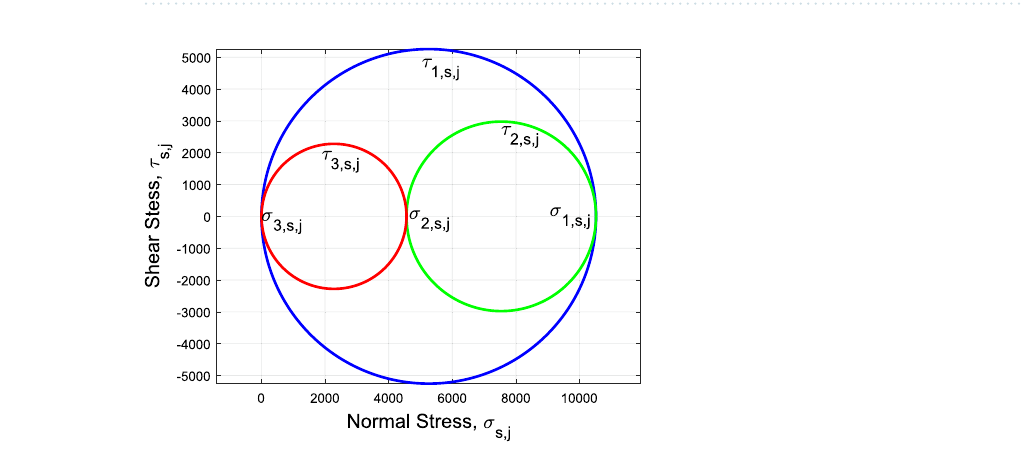
Figure 3. A two-cluster setting, j ∈ C and m = | C | = 2 ( a ) Eigenvalues σ 1, s , j , σ 2, s , j , and σ 3, s , j of matrix Q s , j calculated for node 210. For clustering, the Algorithm 1 is used. ( b ) Distances of node 210 calculated for cluster j = “2” (Eq. 24). ( c ) Position of the center of cluster “1” in the T–D–R space, calculated using the Algorithm 1. Note that j=1 and µ x , µ y , and µ z stand for µ x ,1 , µ y ,1 , and µ z ,1 , respectively.